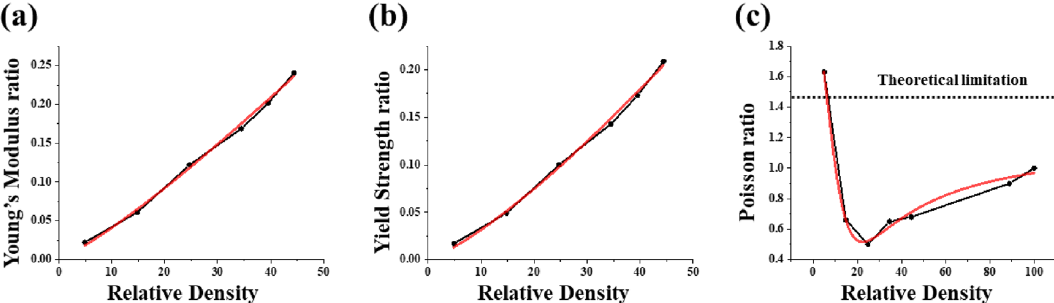
Figure 2. Mechanical properties of the gyroid as a function of relative density: ( a ) young’s modulus, ( b ) yield strength, ( c ) normalized Poisson’s ratio. The dotted line in ( c ) displays the theoretical